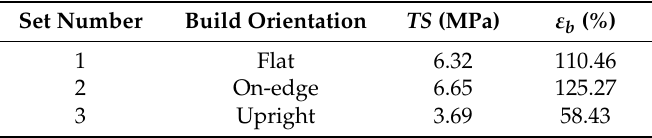
Figure 8. Stress–strain curves of specimens printed in three different directions. Table 4. Average tensile test results of the specimens.